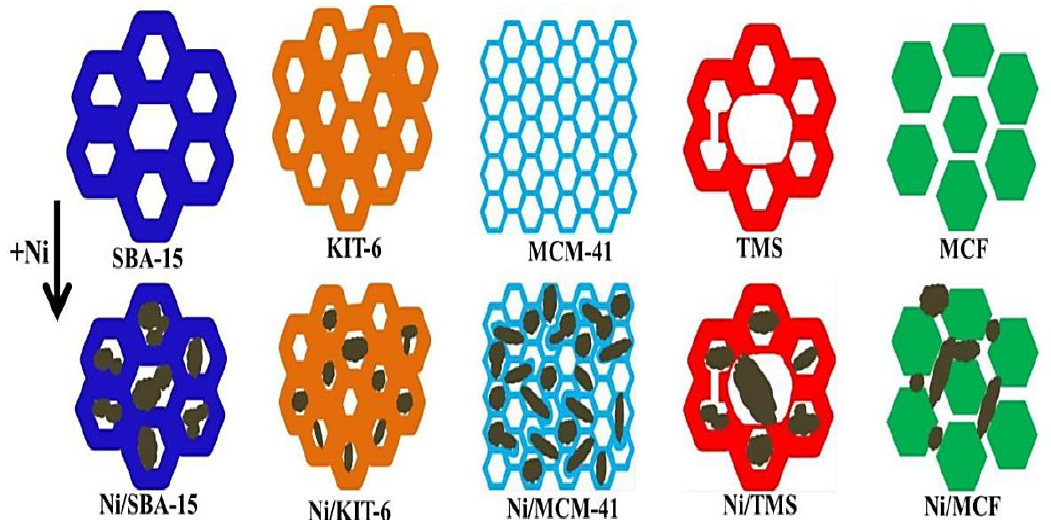
Figure 2. Schematic of the confinement effect on the Ni nanoparticles trapped inside the channels of supports. Reproduced with permission from the authors of [37]. Table 2. Comparison of the properties of various porous silica particles.